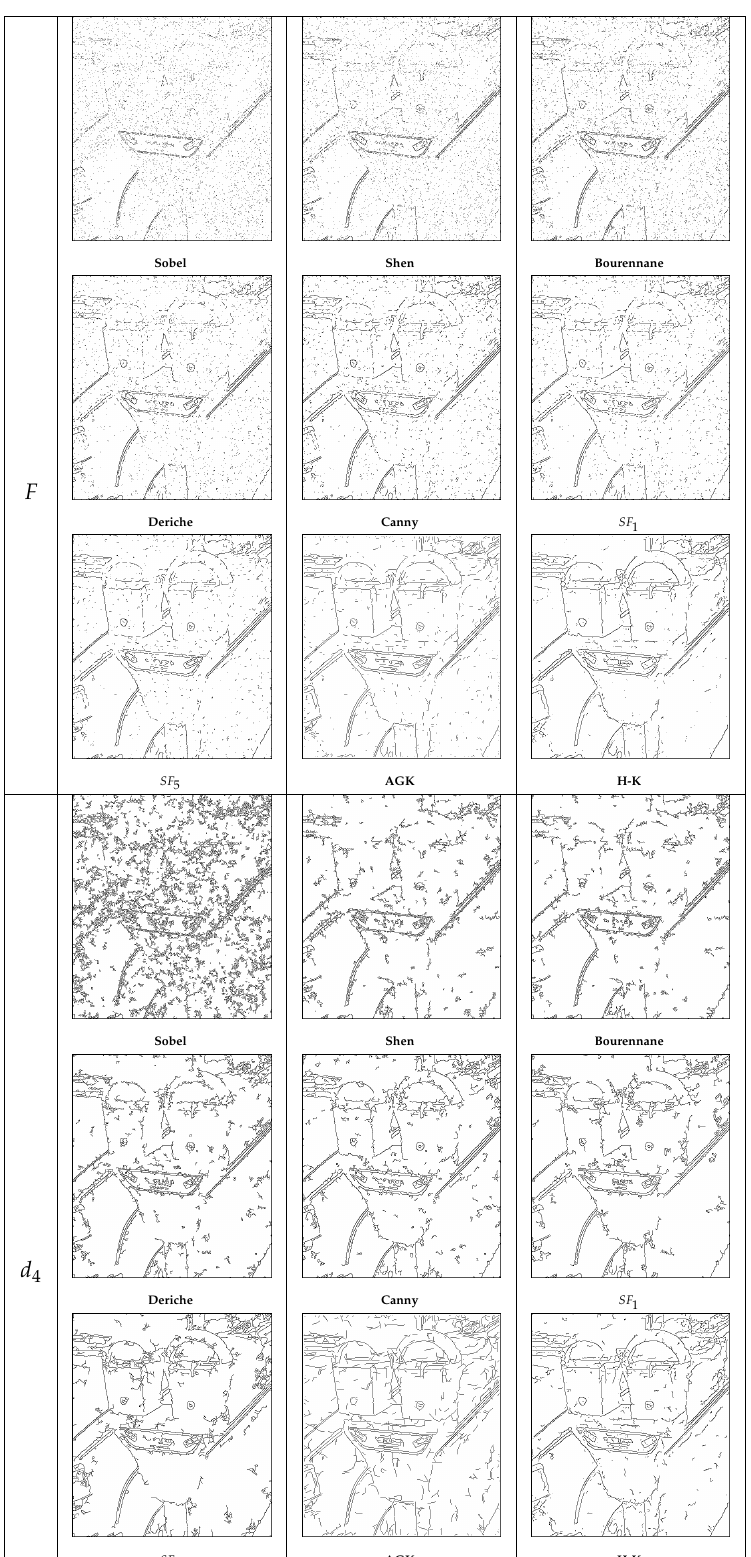
Figure 43. Ideal segmentations for several edge detectors on image parkingmeter, PSNR = 14